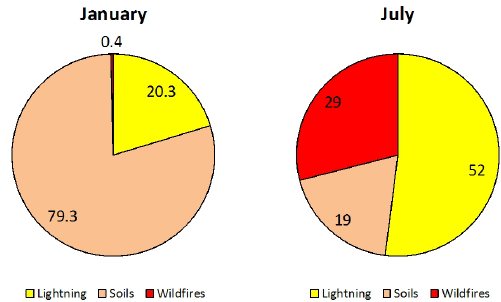
Fig. 4. Percent distribution of natural NO x emissions by source.